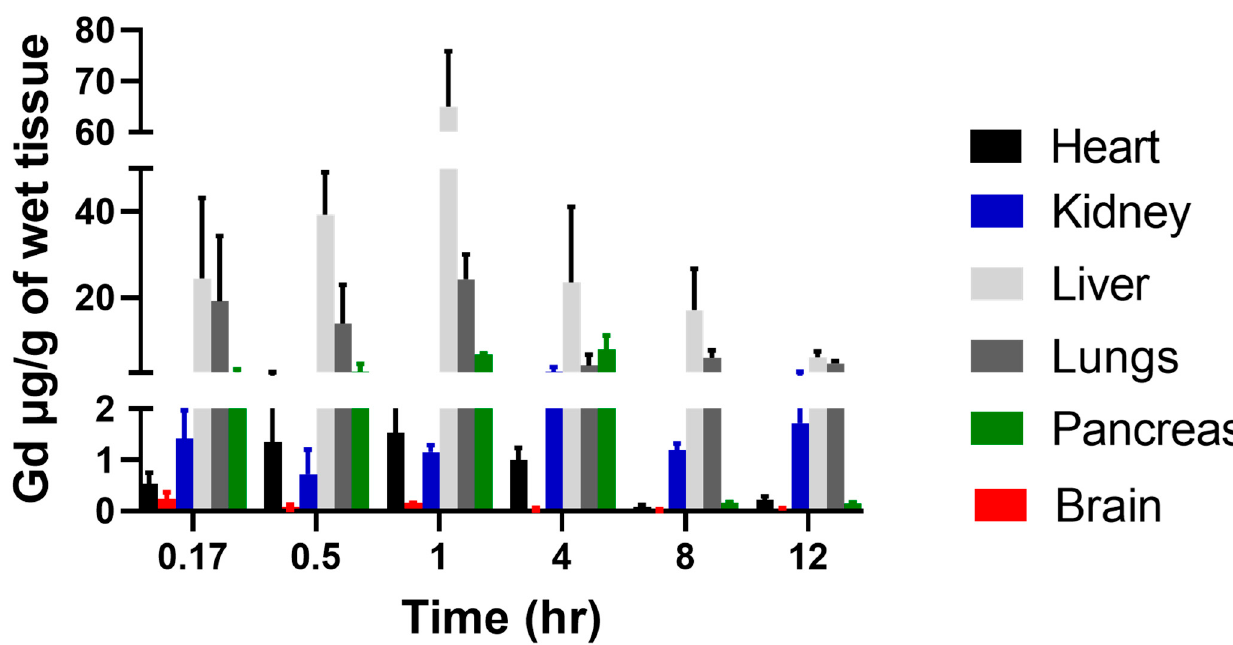
Figure 7. Biodistribution of Gd-Hex-LnP in different tissues (heart, kidney, lungs, brain, liver, and pancreas) at different time points (0.17, 0.5, 1, 4, 8, and 12 h) after IV injection of 0.05 mmol/kg of Gd-Hex-LnP in nude mice. Data represent mean ± SD, number of mice per group = 3.